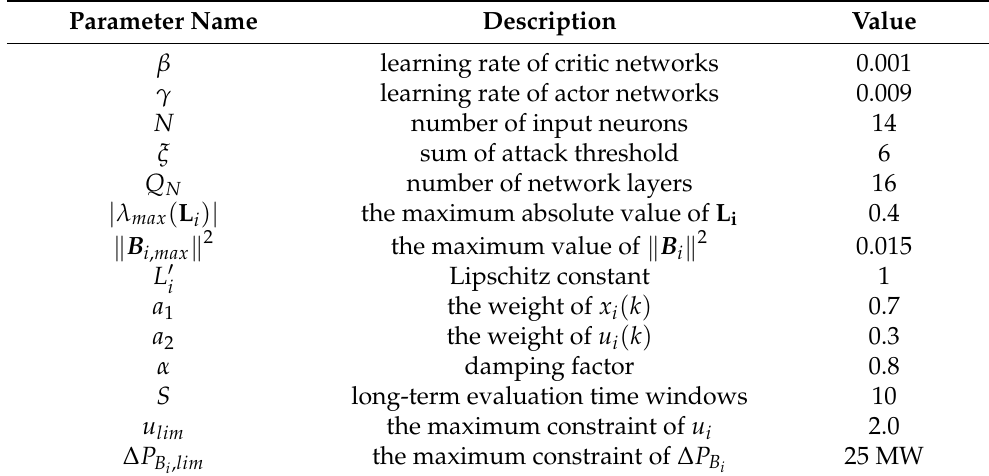
Table 3. Learning parameters of the IEEE14 bus testing